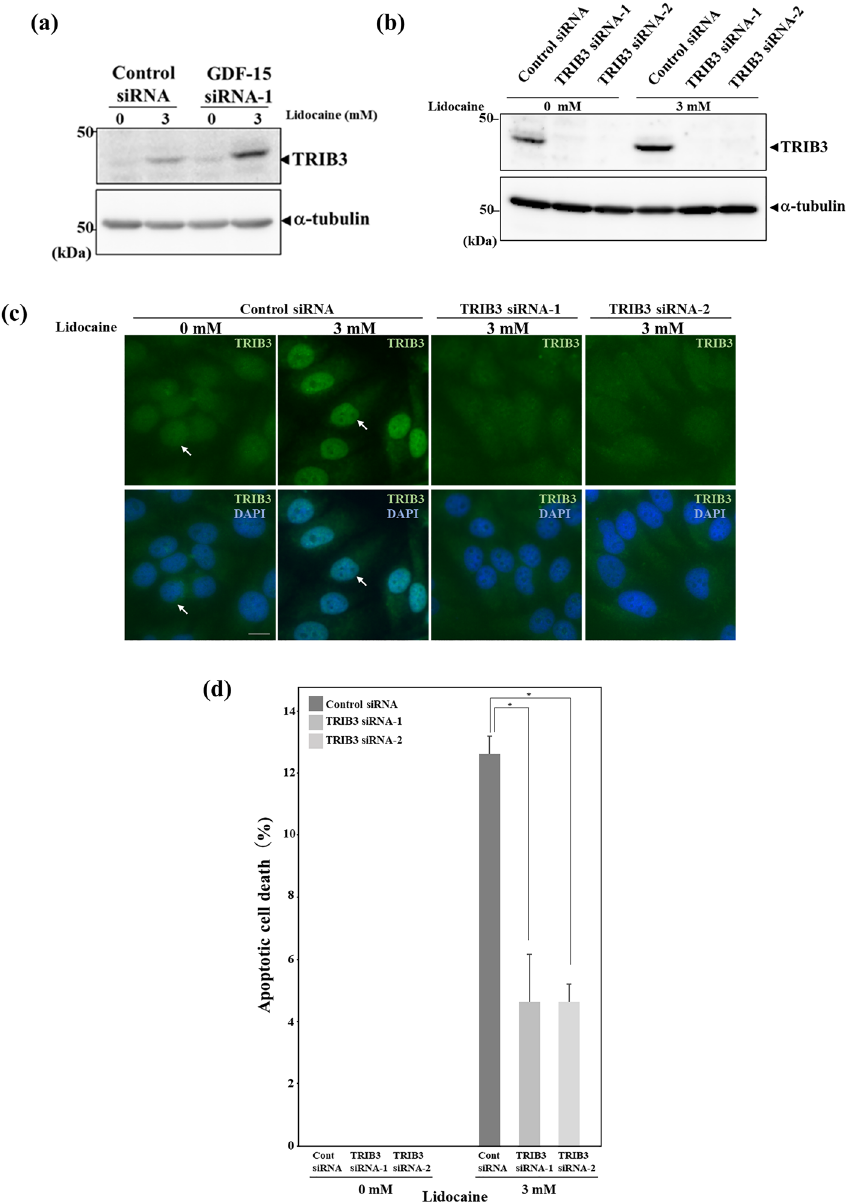
Figure 6. Knockdown of TRIB3 suppresses lidocaine-induced apoptosis. ( a ) TRIB3 expression increased in GDF-15 knockdown HeLa cells after lidocaine treatment. Twenty-four hours after transfection with control or GDF-15 siRNA, HeLa cells were treated with the indicated dose of lidocaine for 24 h. Cell lysates were used for Western blotting using TRIB3 and α-tubulin antibodies. TRIB3 expression increased with lidocaine treatment not only in control but also GDF-15 in siRNA-1 transfected HeLa cells. ( b ) Knockdown of TRIB3 expression by siRNA in Western blotting. Twenty-four hours after transfection with control or TRIB3 siRNA, HeLa cells were treated with the indicated dose of lidocaine for 24 h. Cell lysates were used for Western blotting using TRIB3 and α-tubulin antibodies. TRIB3 was detected in control siRNA-transfected HeLa cells and its expression increased after 3 mM lidocaine treatment. TRIB3 expression was suppressed by TRIB3 siRNA 1 and 2 with and without lidocaine treatment. ( c ) Knockdown of TRIB3 expression by siRNA in immunofluorescence assay. Twenty- four hours after transfection with control or TRIB3 siRNA, HeLa cells were treated with the indicated dose of lidocaine for 24 h and used for immunofluorescence assay using TRIB3 antibody. TRIB3 was detected in the nucleus (arrow in the left panel) and its expression increased after lidocaine treatment (arrow in the second panel from the left). TRIB3 expression was suppressed by TRIB3 siRNA 1 and 2 after lidocaine treatment (right two panels). Nuclei were stained with DAPI. The scale bar represents 10 μm. ( d ) Apoptosis decreased in TRIB3 knockdown HeLa cells after lidocaine treatment. Twenty-four hours after transfection with control or TRIB3 siRNA, HeLa cells were treated with the indicated dose of lidocaine for 24 h and used for assay. The number of apoptotic cells with chromosome condensation visualized by DAPI staining were counted. Each sample of one hundred cells was counted in triplicate. The results are presented relative to the total cell number and expressed as the mean ± SD. * p <